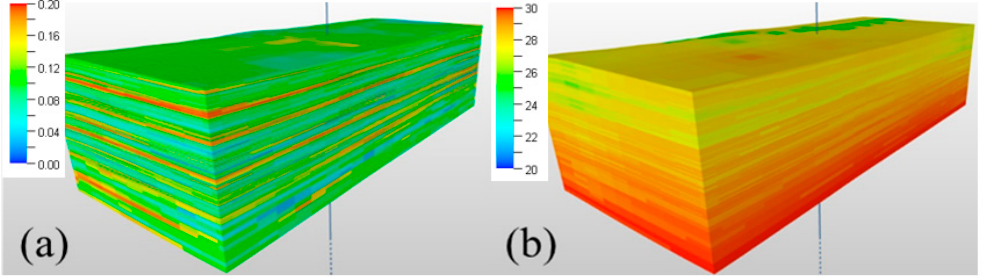
Figure 25. Three-dimensional porosity and minimum principal stress modeling results. ( a ) Porosity; ( b ) minimum principal stress.